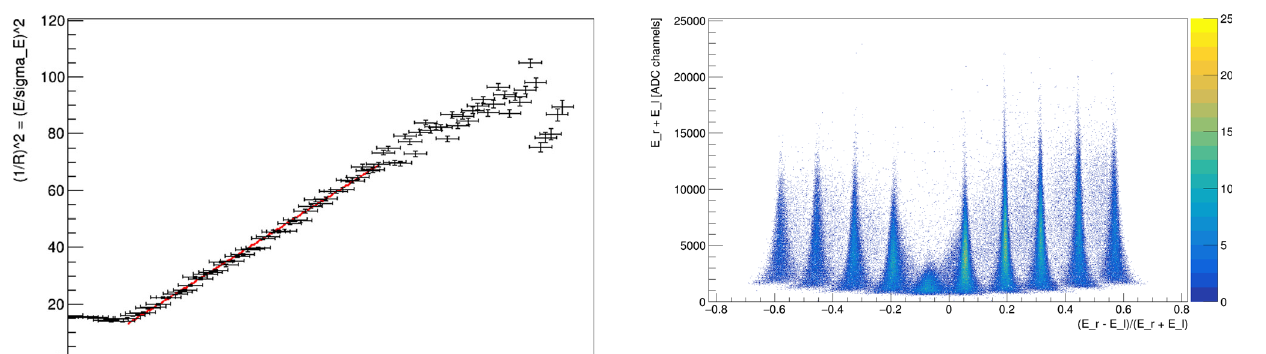
Fig. 27 Correlation of the total energy E l + E r against the energy asymmetry ( E r − E l )/( E r + E l